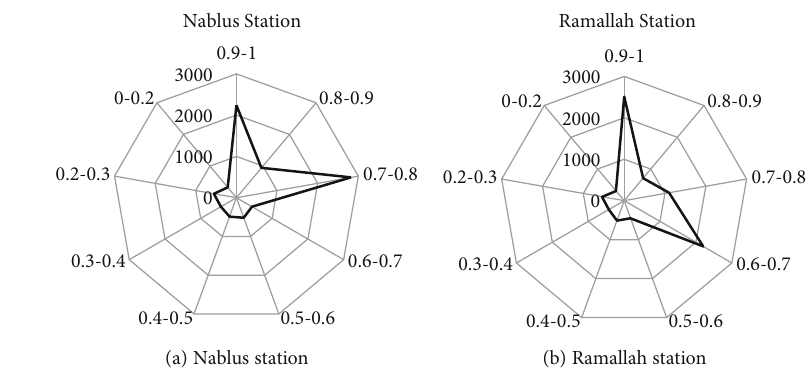
Figure 13: Usage of battery in Nablus station and Ramallah